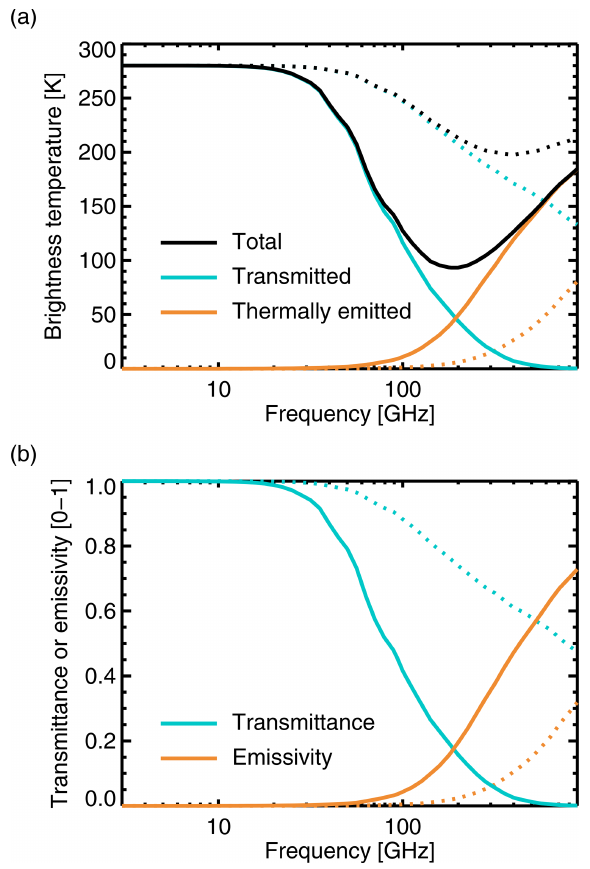
Figure 11. (a) Brightness temperatures, divided into the transmitted and emitted parts of Eq. (21); (b) transmittance and emissivity of the same cloud, i.e. the terms in square brackets in Eq. (21). This is a standard cloud with a thickness of 2km (solid) or 0.2km (dotted), with the ARTS ICON hail particle, F07 T PSD, and other settings as seen in Figs. 9 and